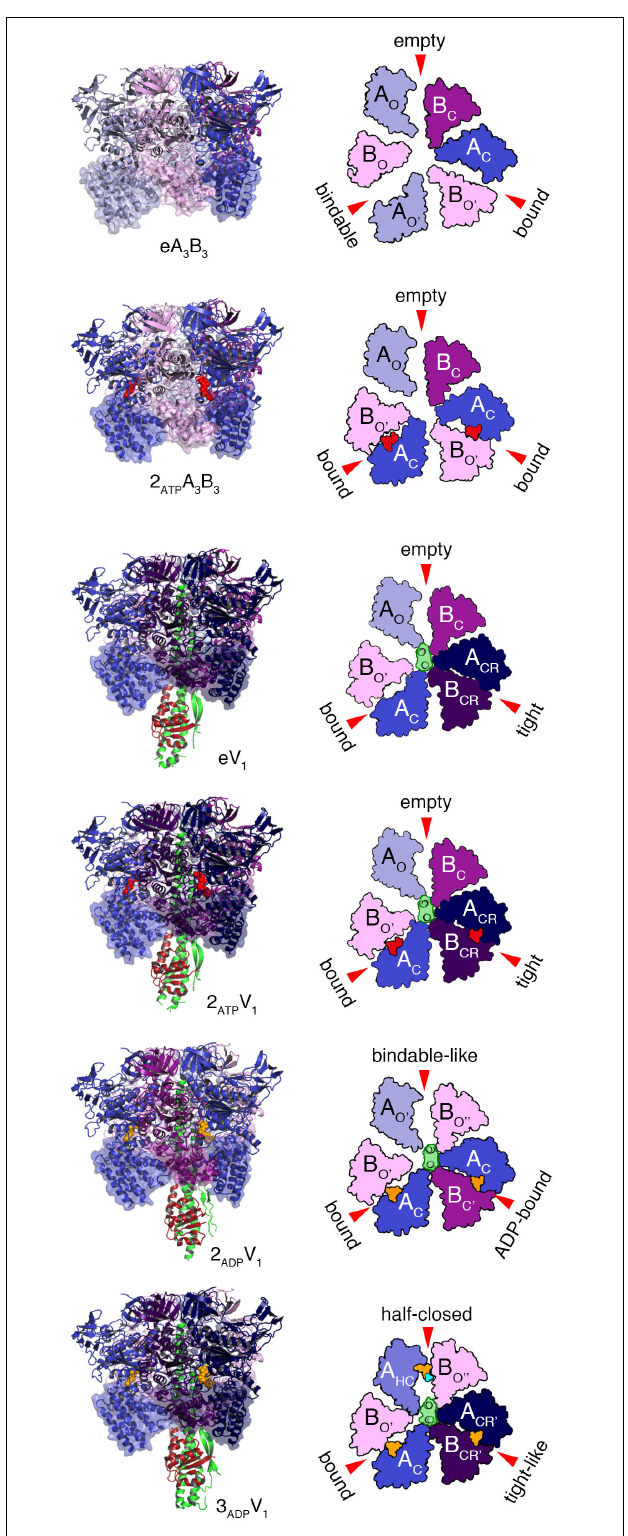
FIGURE 2 | Crystal structures of the A 3 B 3 and A 3 B 3 DF (V 1 ) complexes with or without the nucleotides. Left panels from top to bottom; side